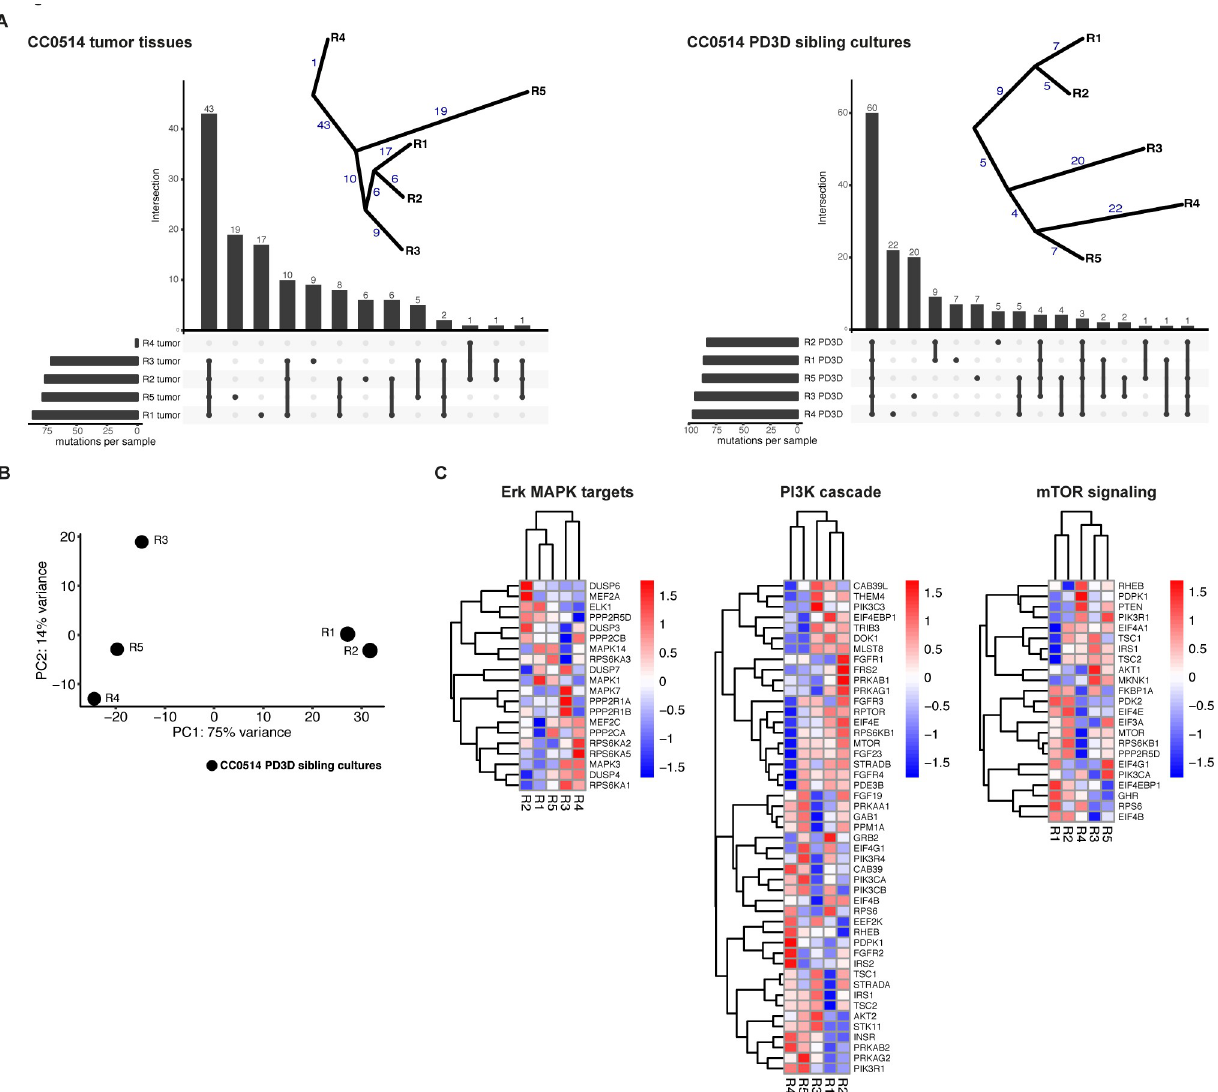
Fig 6. Tumor tissues and sibling cultures of patient CC0514 display genetic heterogeneity and heterogeneous mRNA expression profiles. Heterogeneity of tumor tissues and PD3D sibling cultures was evaluated on DNA and mRNA levels. ( A ) On the genomic level, somatic mutations were called from DNA of the five original tumor pieces (R1-R5) of the primary tumor of patient CC0514 and the respective PD3D sibling cultures, compared to CC0514 patient´s blood. Cellular content of tumor tissue R4 was very low. UpSet plots show rare somatic mutations (MAF < 0.001) in exonic regions used to construct evolutionary trees of the somatic mutations, displayed next to the plots. The numbers of shared or private mutations are given. ( B ) Principal Component Analysis of the mRNA expression of the sibling cultures. First component on x-axis contains 75% of the variance and classifies the samples into two major groups R1/R2 vs. R3/R4/R5). ( C ) Heatmaps of mRNA expression of components of ERK/ MAPK, PI3K and mTOR signaling pathways. Each row has been transformed using Z-score. The color code represents the scaled mRNA expression across samples. Genes and samples were hierarchically clustered using Euclidean